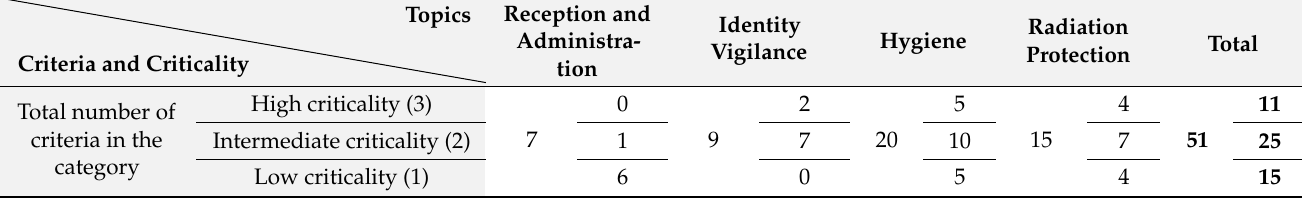
Table 1. Distribution of the audited items according to their theme and